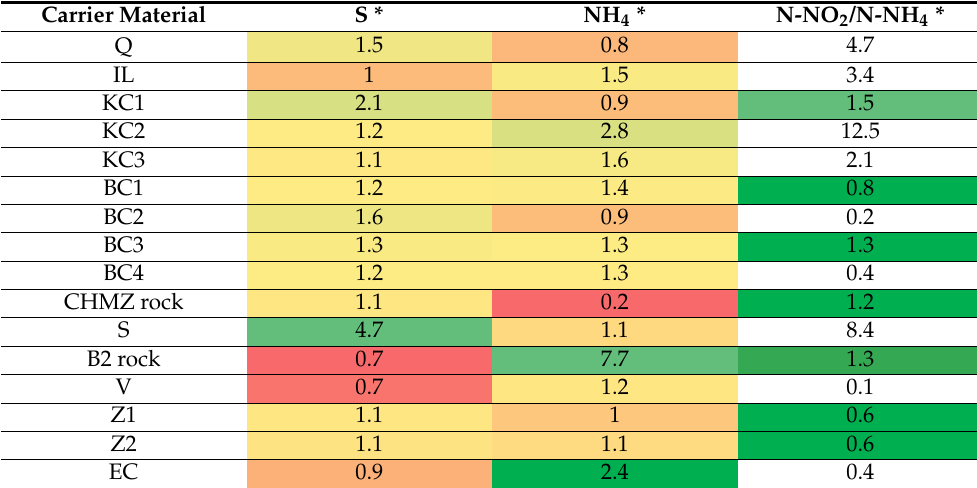
Figure 6. Biofilm area on carriers after bioaugmentation with a “warm” anammox community, % according to confocal microscopy ( A ) and rates of ammonium and nitrite consumption ( B ). Table 4. Heat map of N-NO 2 /N-NH 4 ratio and changes in biofouling and NH 4 consumption rate after bioaugmentation with a “warm” anammox community.